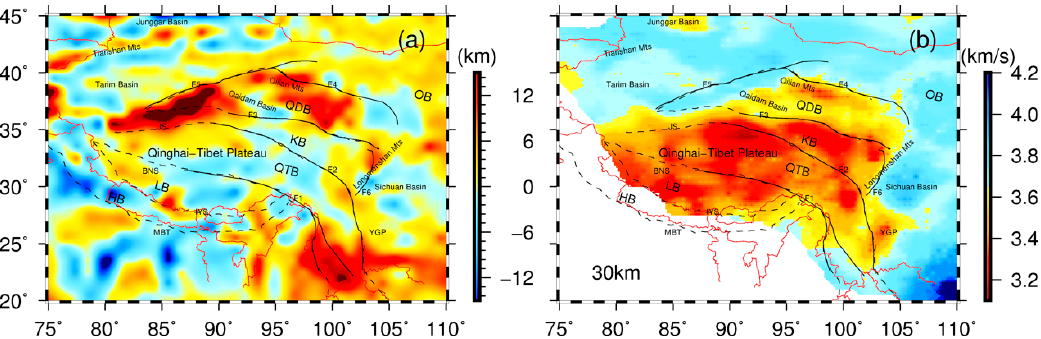
Figure 8. ( a ) Moho depth differences between MJ and CRUST 1.0; ( b ) shear wave velocity at the depth of 30 km.